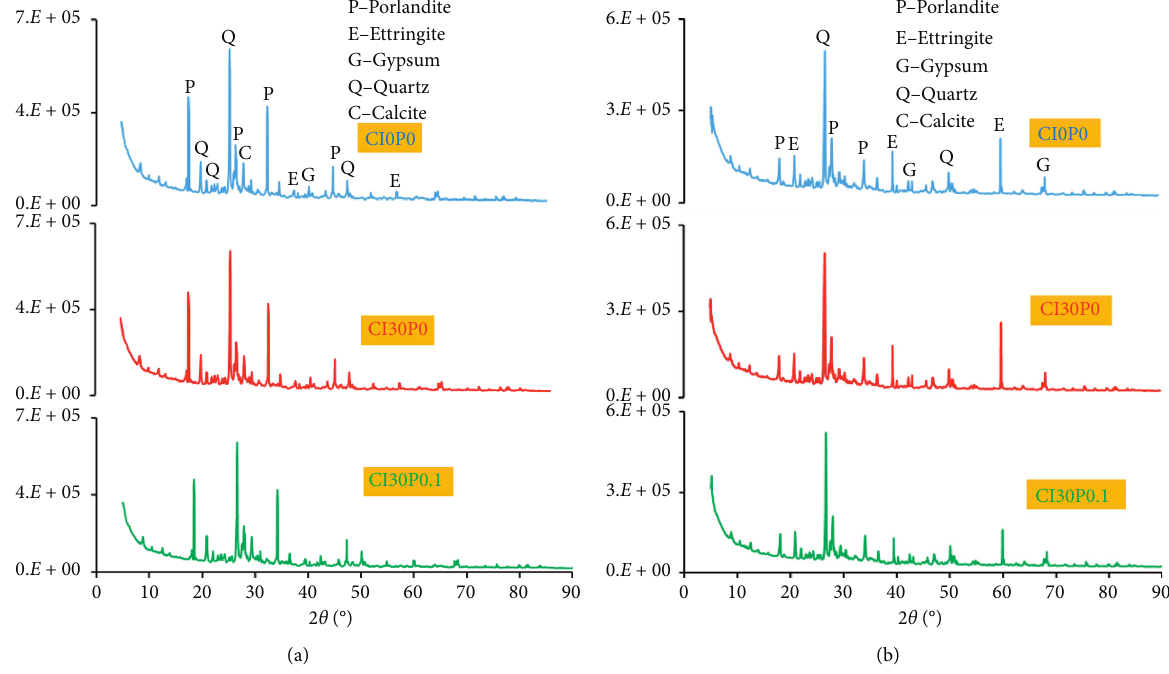
Figure 9: XRD patterns of pastes exposed to drying-wetting cycles in 5% Na